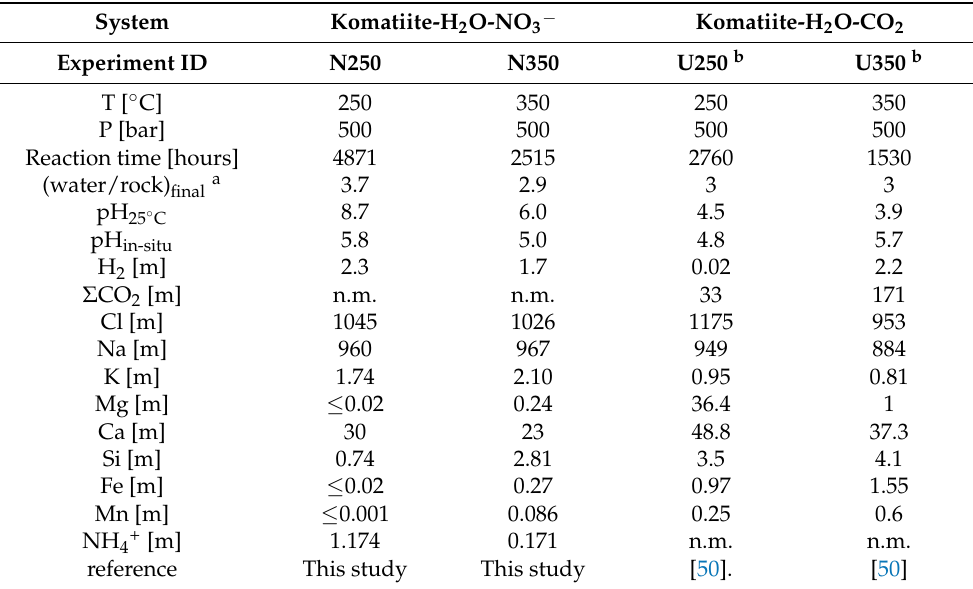
Table 3. Steady-state composition of aqueous fluids in the komatiite–H 2 O–NO 3 − and komatiite– H 2 O–CO 2